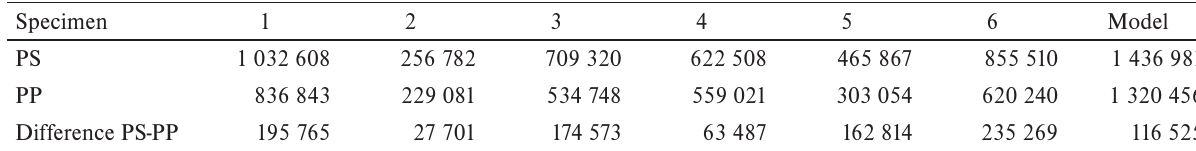
Table 3. Bending stiffness values [MPa∙mm 4 ] for loading option b.